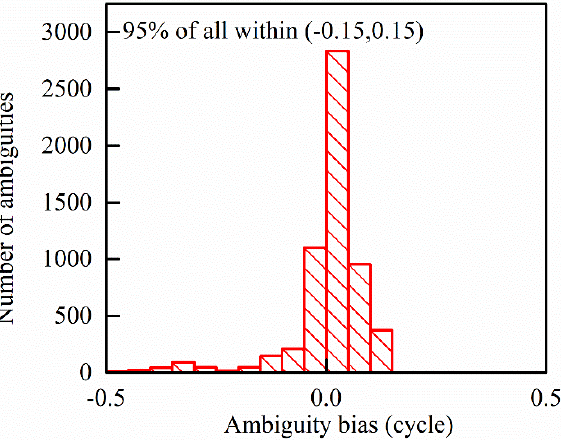
Figure 2. The distribution of the ambiguity substitution approach SD-Float ambiguity biases.